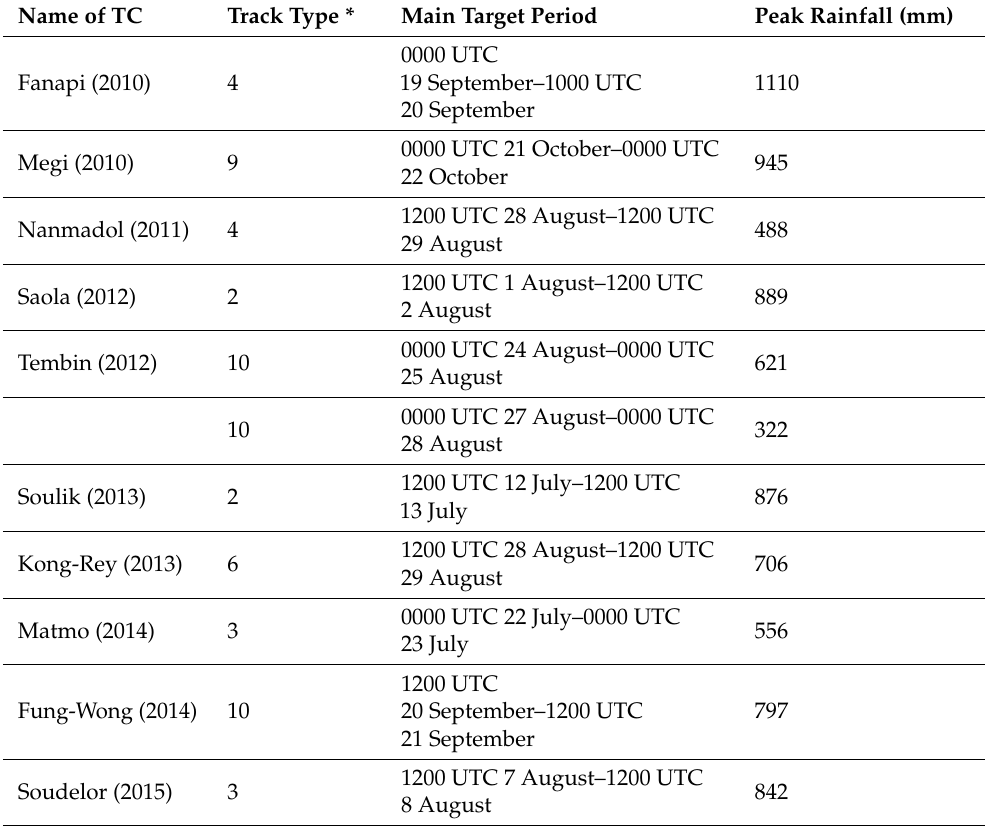
Table 2. List of the 10 typhoons in this study, including their name and year, CWB track type *, main target period (24 h in length, 0000-0000 or 1200-1200 UTC), and observed peak rainfall amount (mm) over that period. Due to its special track, two target periods are chosen for Tembin (2012). Results of Fanapi (201) and Megi (2010) are taken from W15 [30], and Soulik (2013) from W21 [31]. Name of TC Track Type * Main Target Period Peak Rainfall